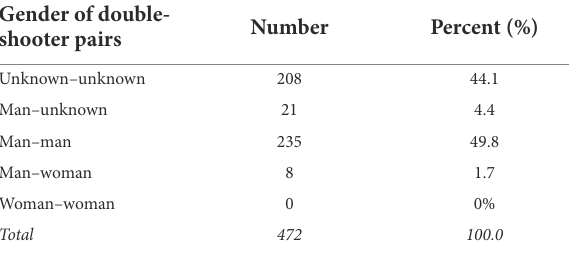
TABLE 6 Gender of double-shooter pairs in overall sample.